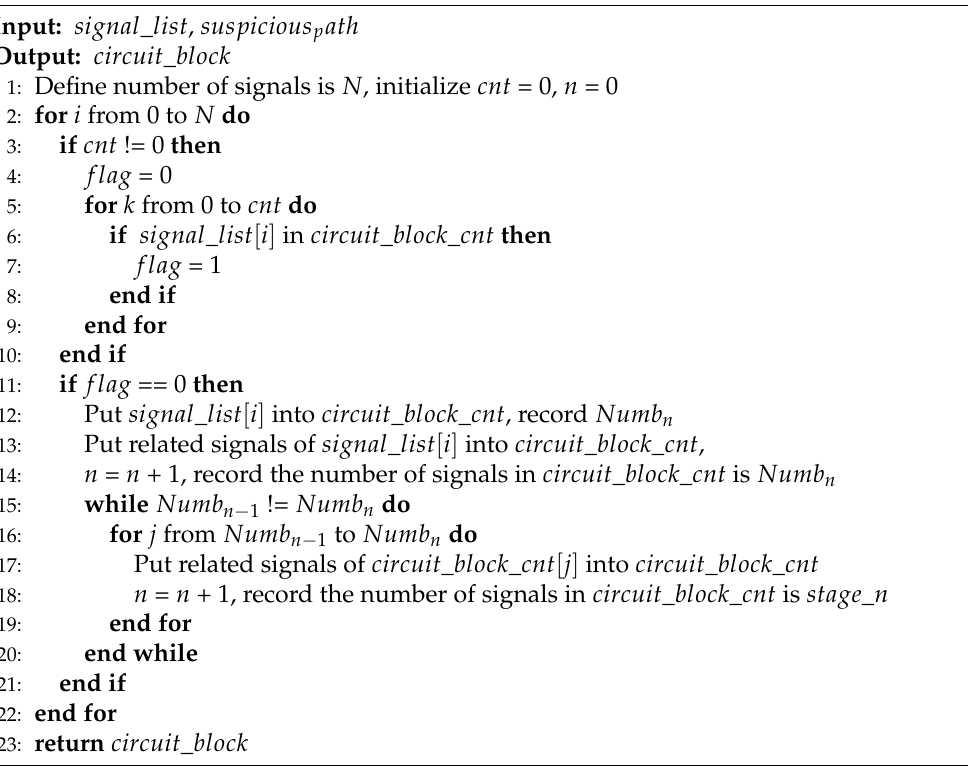
Algorithm 2 Suspicious circuit block